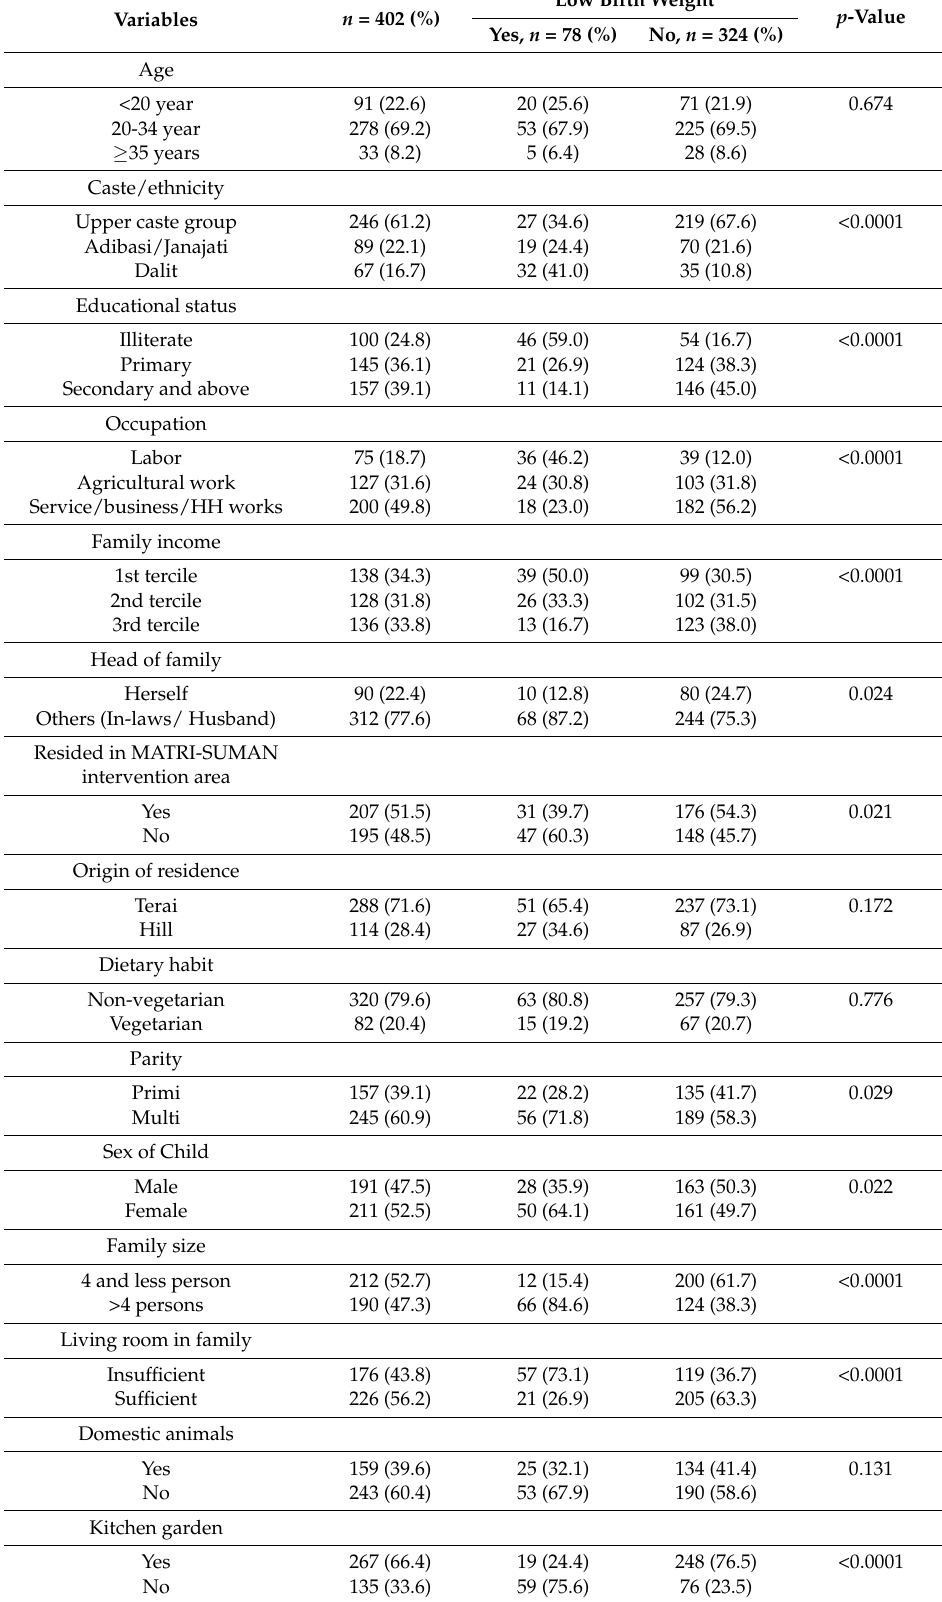
Table 1. Association between maternal factors and low birth weight (LBW)